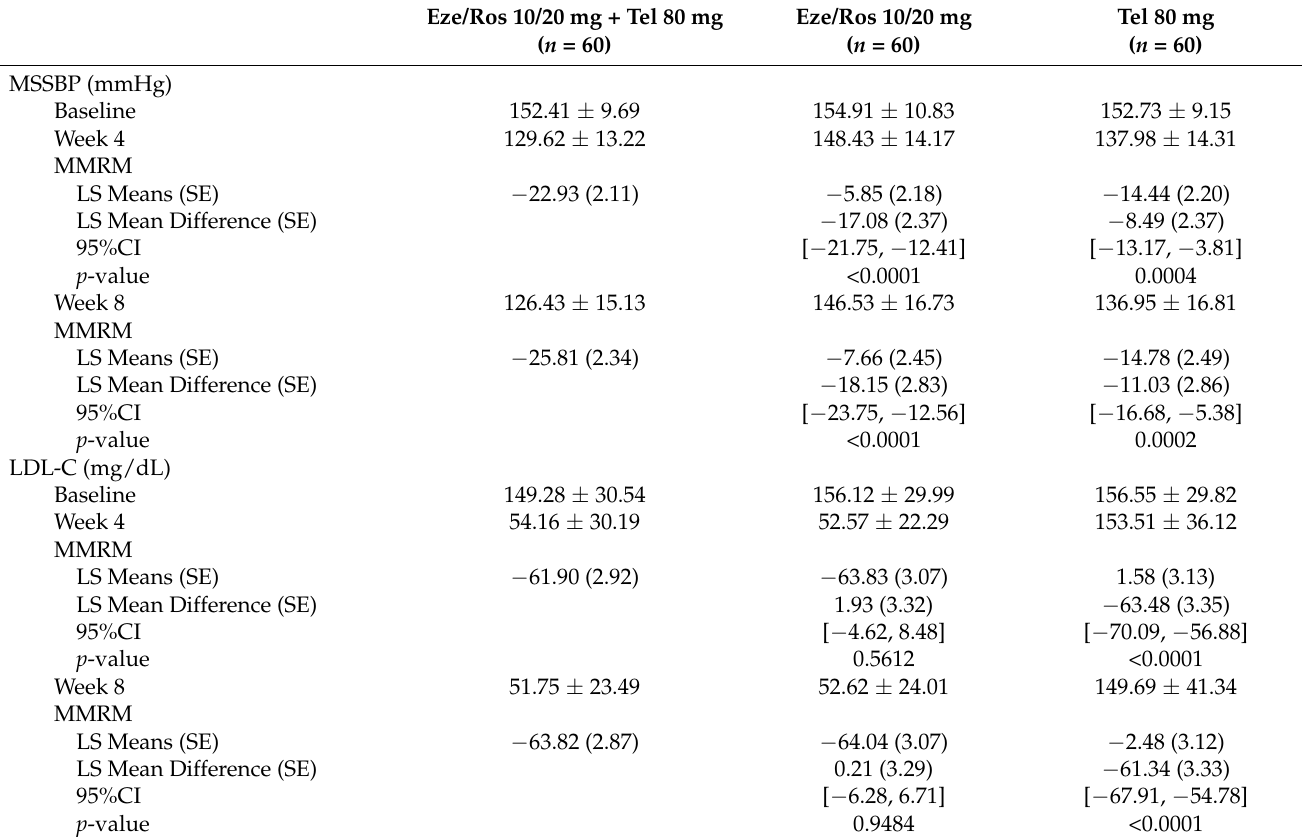
Table 2. Changes from baseline in MSSBP and LDL-C at week 4 and week